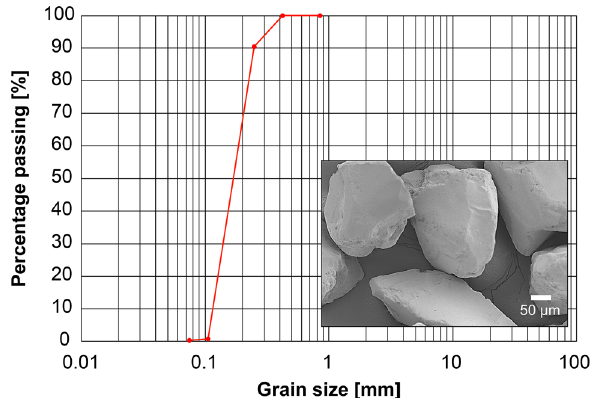
Figure 8. Particle-size distribution (red line with dots) and an SEM image (lower right corner) of the Toyoura